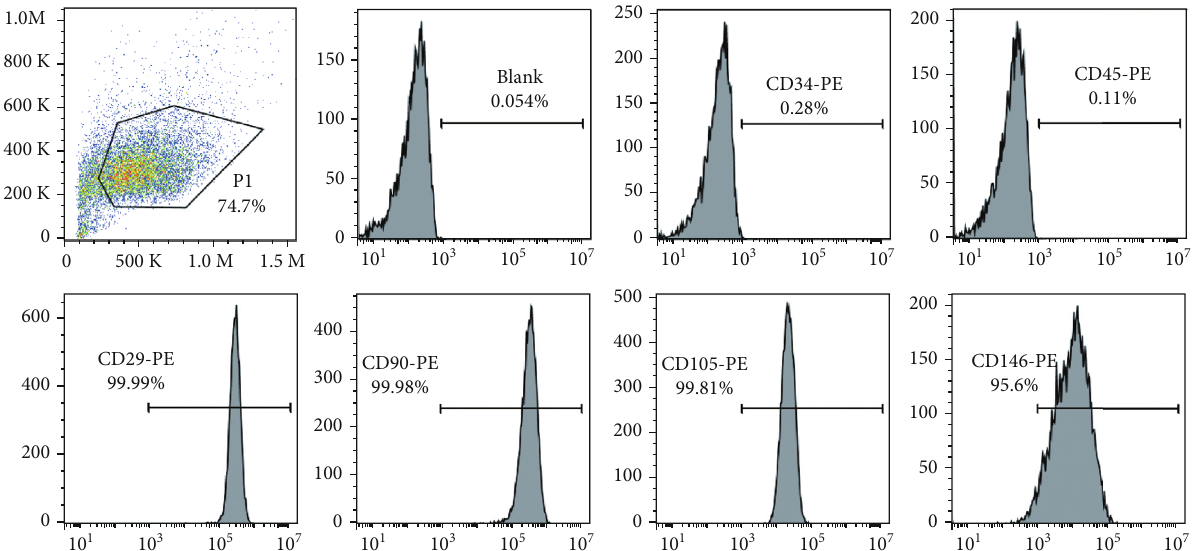
Figure 1: Phenotype of hDPSCs. Flow cytometric analysis showed hDPSCs strongly expressed high level of the mesenchymal stem cell (MSC) markers CD29, CD90, CD105, and CD146, but expressed negative expression of the hematopoietic cell markers CD34 and